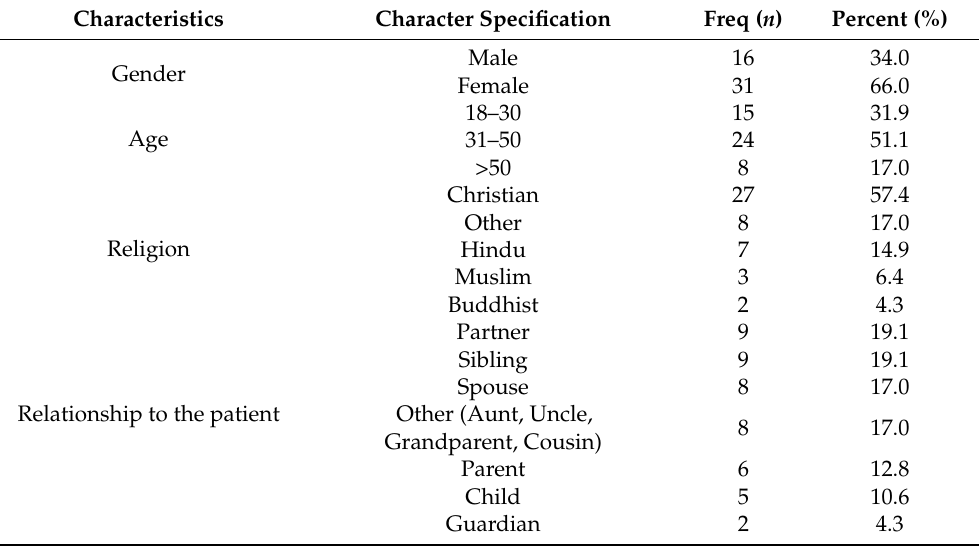
Table 1. Sociodemographic variables of respondents ( n = 47).